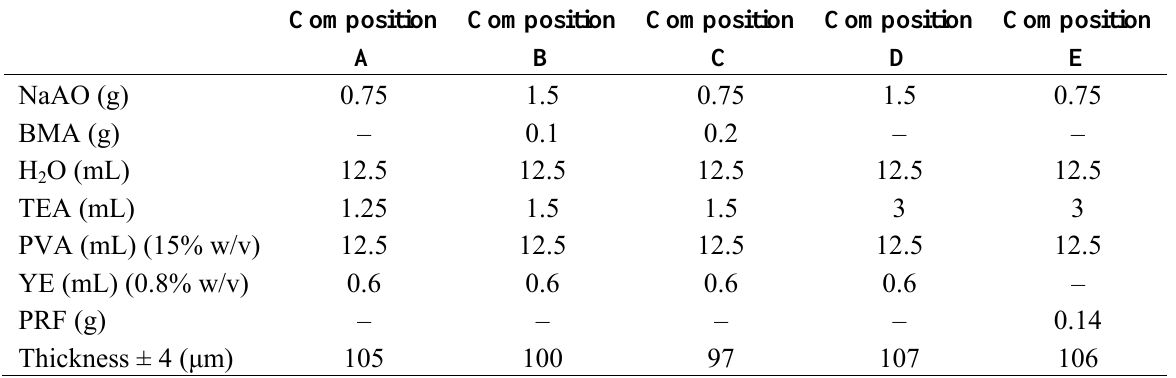
Composition A B C D